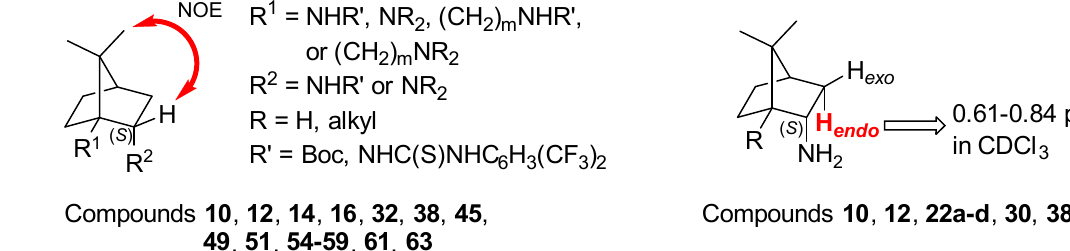
Figure 4. Determination of the absolute configuration at C-2 based on the observed NOE correlation spectroscopy cross peaks and chemical shift correlations in the series of primary endo -amines.